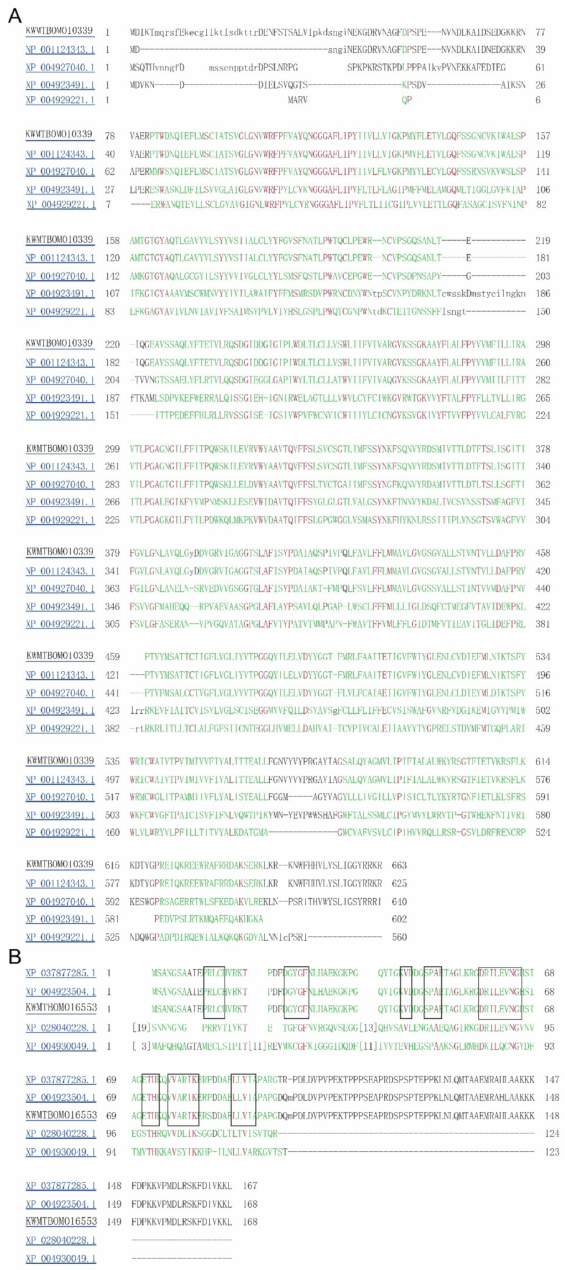
Figure 5. Multiple amino acid sequence alignment. ( A ) The alignment of KWMTBOMO10339 homologous protein; ( B ) The alignment of KWMTBOMO16553 homologous protein, the black box indicates the PDZ domain. Multiple sequence alignment columns with no gaps are colored in blue or red. The red color indicates highly conserved columns and blue indicates less conserved